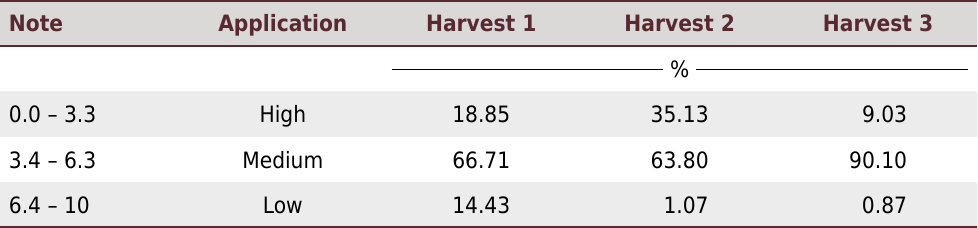
Table 5. Percentage determination of the areas with input application grades